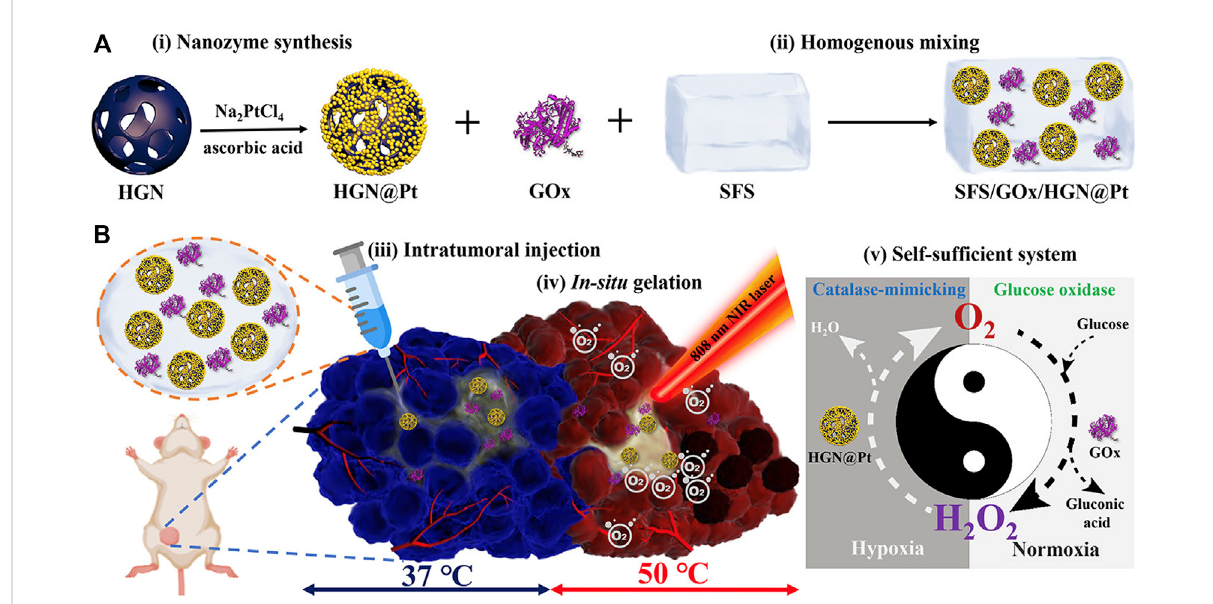
FIGURE 6 (A) Synthetic procedure and composition and (B) Schematic representation of the mechanism of the self-suf fi cient hybrid enzyme-based hydrogel system for thesynergisticalleviationof tumor hypoxiaand induction oftheanti-cancer effect when combined with irradiation froman NIR laser (Wu et al., 2021). Copyright © 2021 American chemical